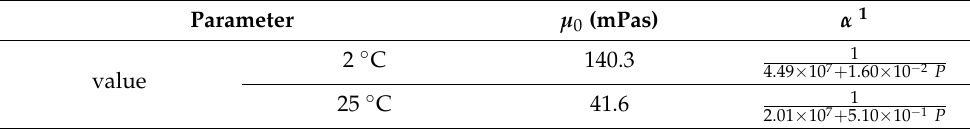
Table 2. The values of µ 0 and α corresponding to the working conditions of 25 ◦ C and 2 ◦ C [8].